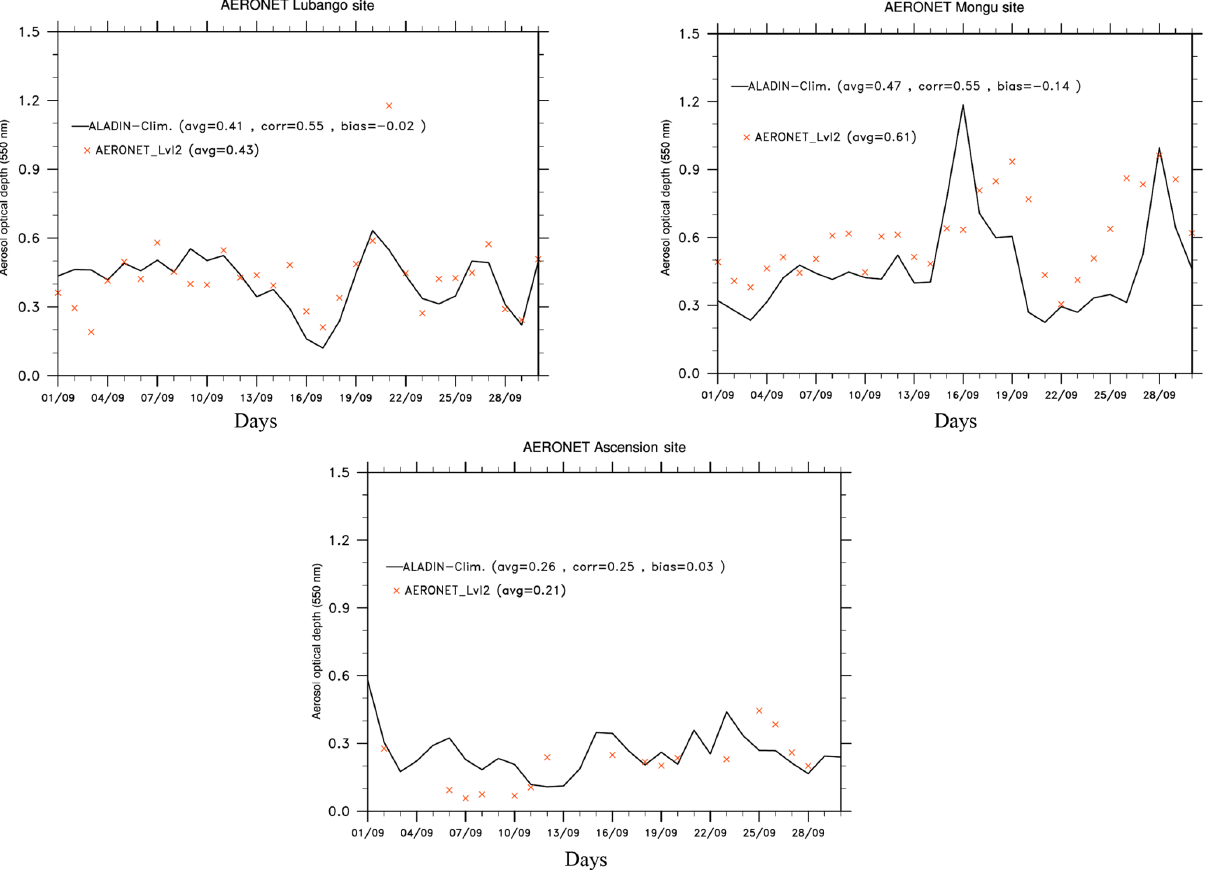
Figure 5. Comparisons of daily mean total AOD obtained at the Lubango, Mongu Inn and Ascension Island AERONET stations (daytime model outputs only) for September